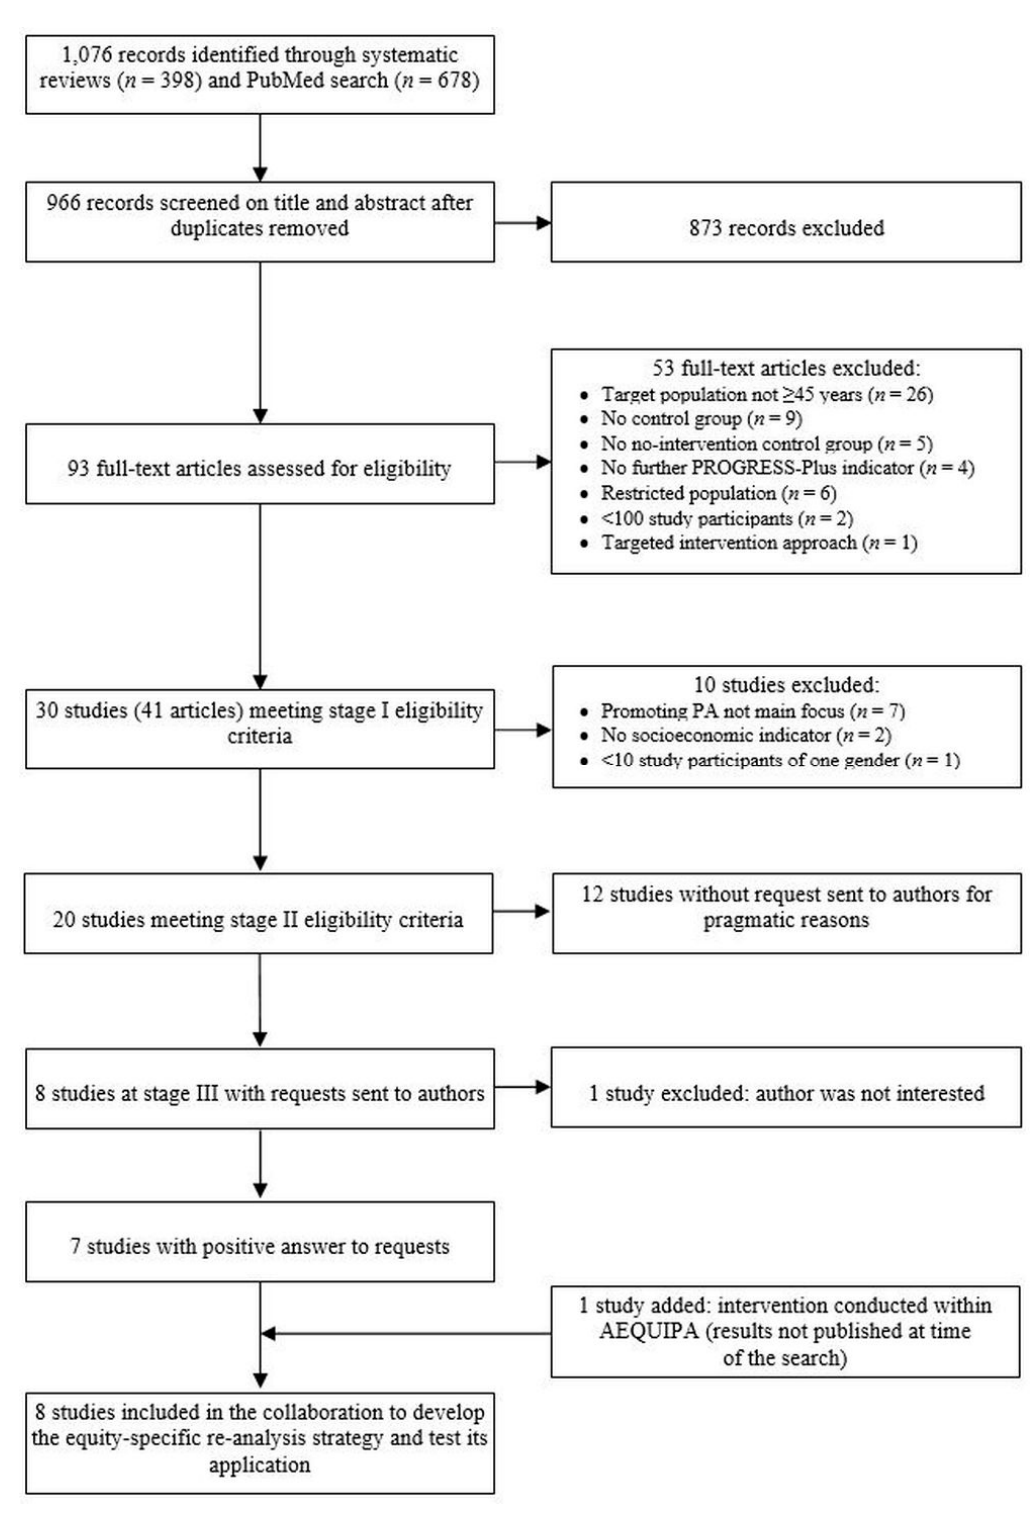
Figure 1. Flow chart of study selection.